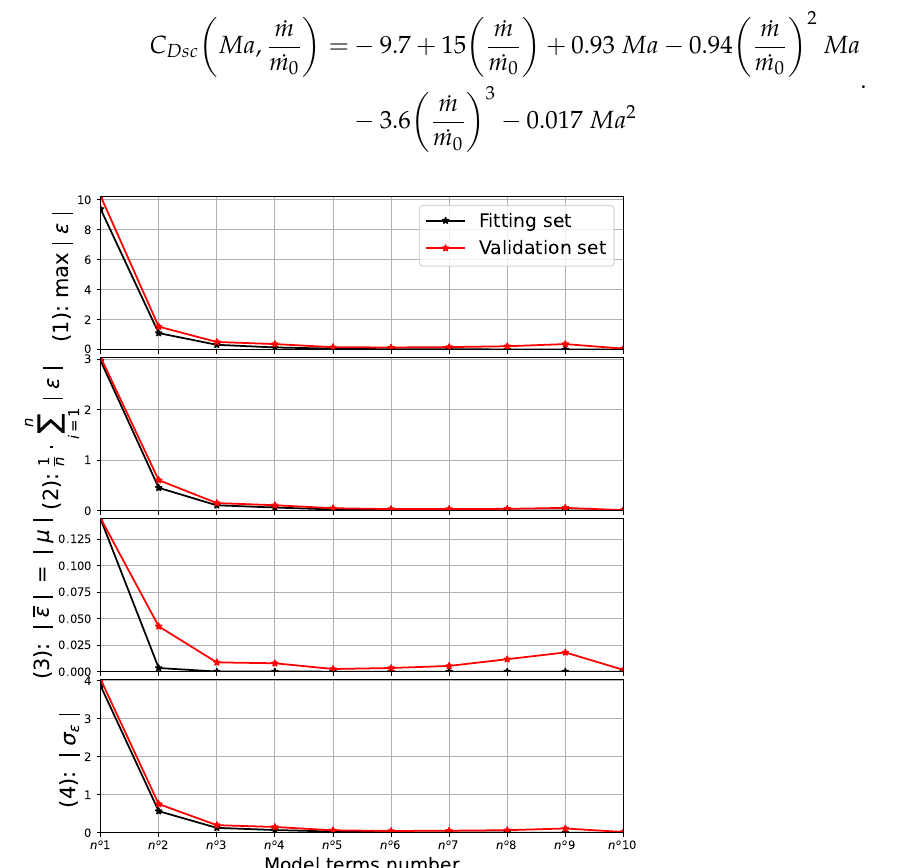
Figure 6. Output of regression model performed on C Dsc —errors and standard